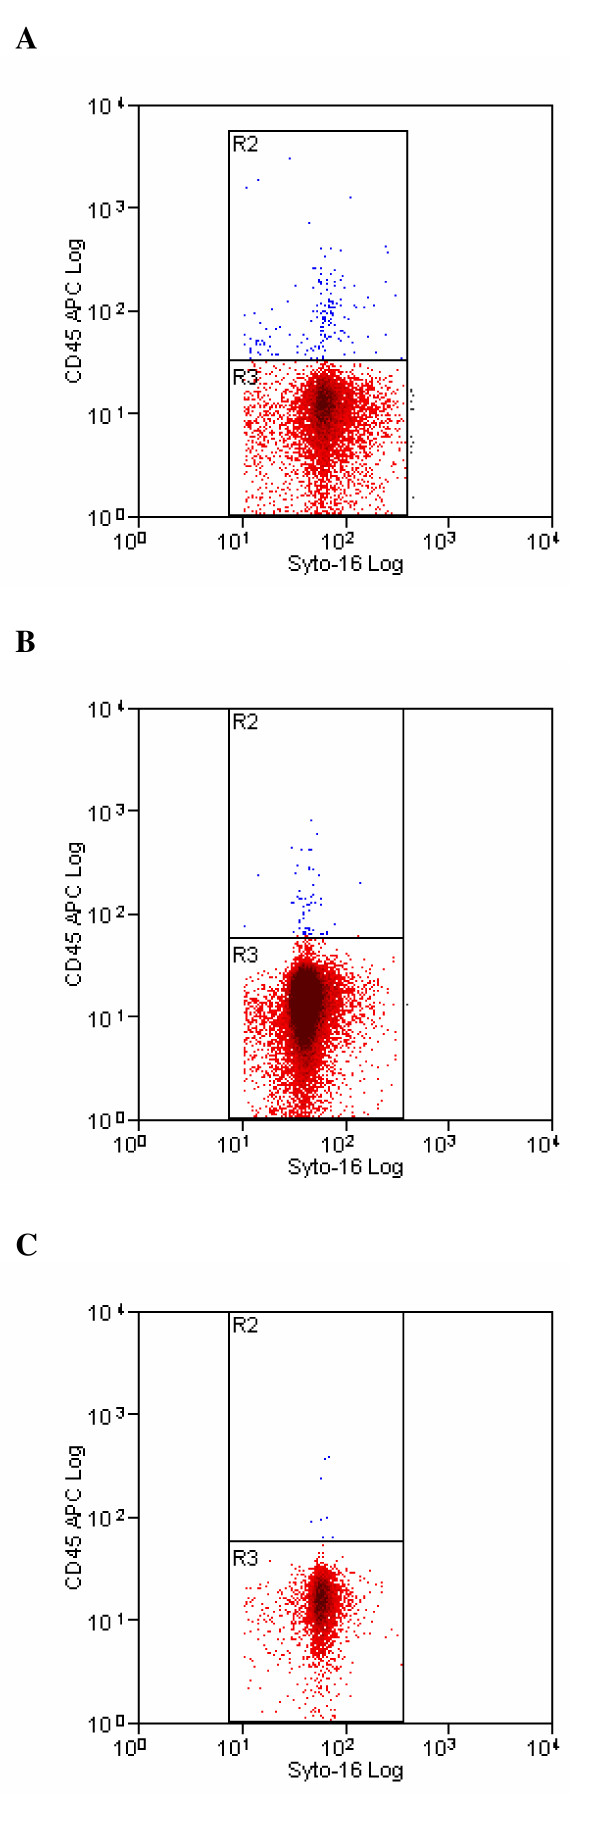
Pre- (2a) and post-processing (2b, 2c) cytofluorimetric analysis of a semen sample with a low leukocyte concentration. Cytogram 2a displays the cytofluorimetric analysis of a semen sample containing a low concentration of leukocytes, stained with Syto-16 and CD45 to identify sperm and leukocytes. Region R2 (blue colour) and Region 3 (red colour) represent the number of leukocytes and sperm counted, respectively. Cytograms 2b and 2c displays the cytofluorimetric analysis of the same sample after density-gradient centrifugation and after swim-up technique, respectively.